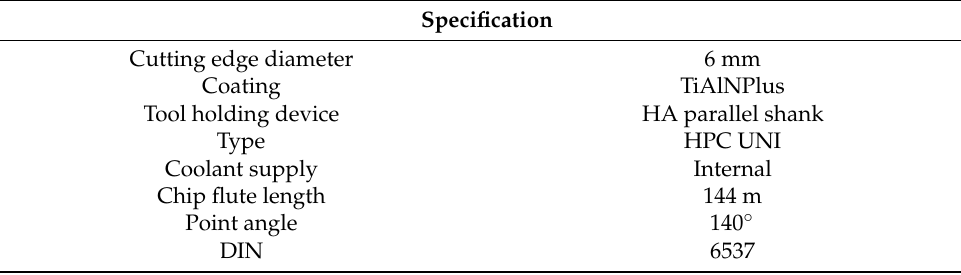
Table 4. Parameters of the drill bit